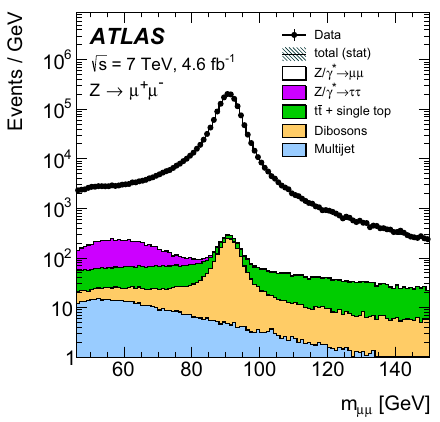
Fig. 14 The dilepton invariant mass distributions for Z /γ ∗ → μ + μ − candidates. The simulated samples are normalized to the data luminos- ity. The multijet background shape is taken from a data control sample and normalized to the estimated yield of multijet events. The sum of all expected background and signal contributions is shown as a solid line with a hashed band detailing the statistical uncertainty and labelled “total (stat)”. The legend lists only background sources with a visible contribution